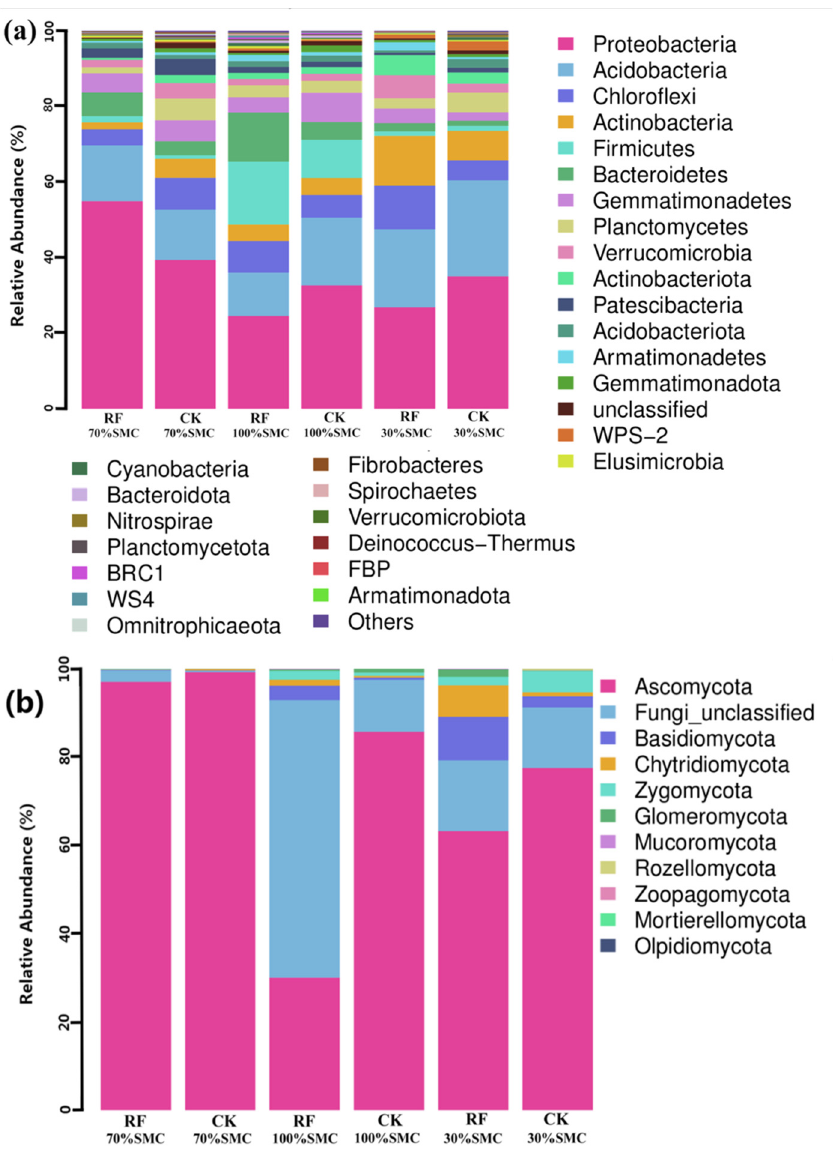
Figure 6. Soil microbial community structure analysis of control samples and after RF application at different SMCs (( a ) bacteria; ( b ) fungi) (phylum levels).